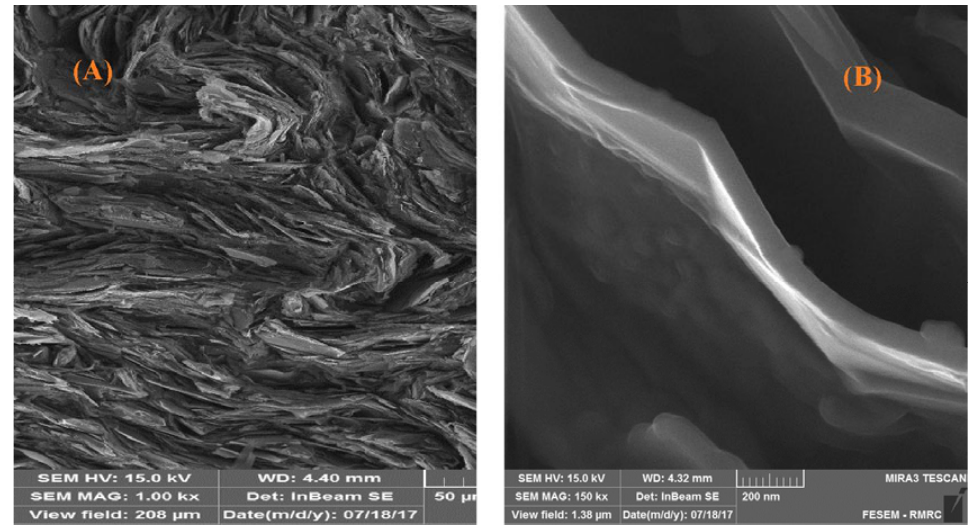
Fig. 2 . SEM of GF modified PGEat different magnification (A) at 1.0 Kx and (B) at 150